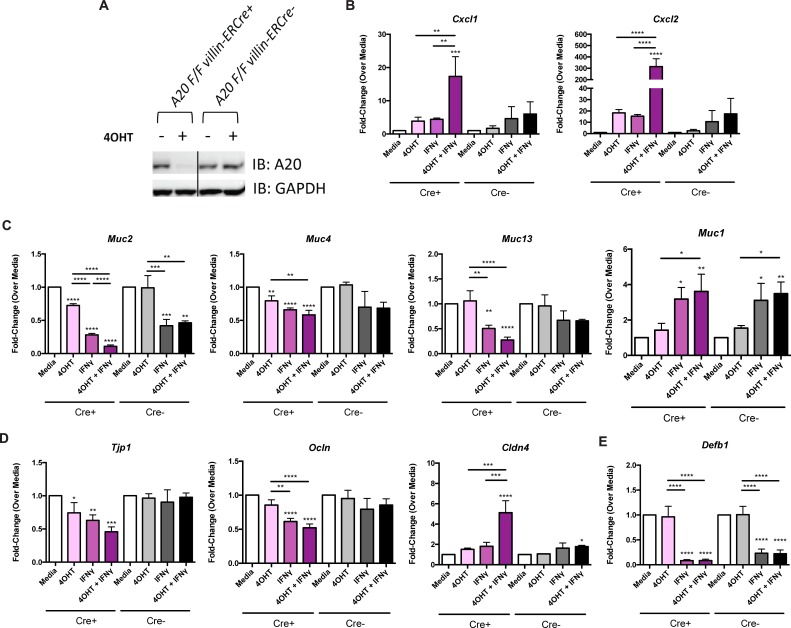
A20 deletion is associated with enhanced IFNγ-mediated inhibition of tight junction and mucin gene expression.(A) Western blot for A20 protein levels in A20FL/FL villin-ERCre+ or Cre- organoids after treatment with 4-hydroxytamoxifen (4OHT) for 24 hours. Gene expression by qPCR of (B) the proinflammatory chemokines Cxcl1 and Cxcl2, (C) the mucins Muc2, Muc4, Muc13, and Muc1, (D) the tight junction proteins Tjp1, Ocln, and Cldn4, and (E) the antimicrobial peptide Defb1 after stimulation with IFNγ for 12 hours. Statistical significance within Cre+ and Cre- conditions was first tested by ANOVA and specific pairwise comparisons were made using t-tests corrected for multiple comparisons by the Scheffe method (see also S1 Table). Stars above each column indicate statistical significance relative to the media condition. Bars with stars indicate statistically significant differences between the two indicated conditions. * P<0.05, **P≤0.01, ***P≤0.001, ****P≤0.0001.